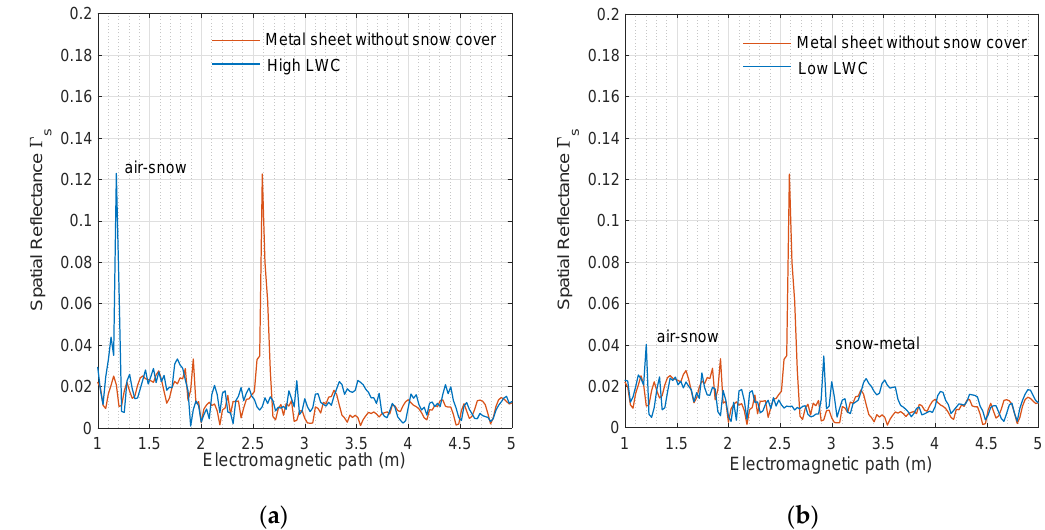
Figure 16. Spatial reflectances of two measurements compared with the metal sheet without snow cover case (orange): ( a )